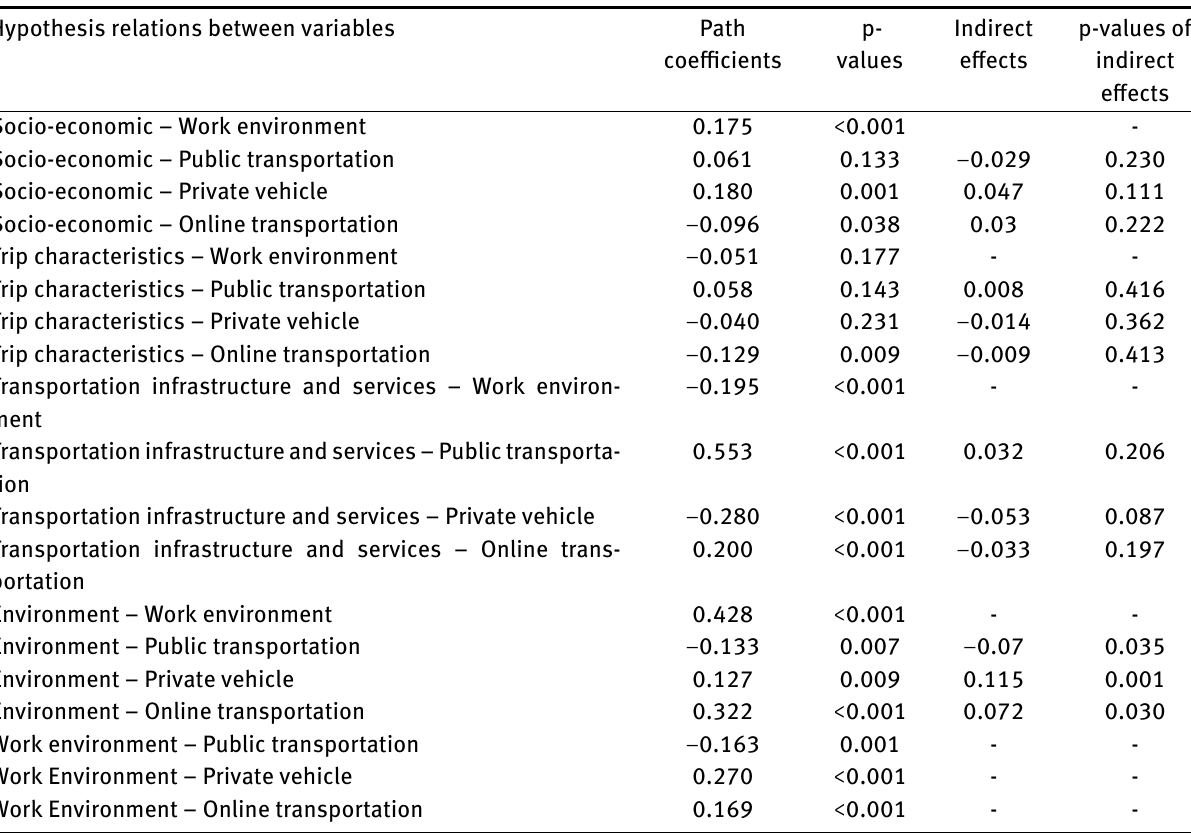
Table 8: Output test the relationship between variables in the model Hypothesis relations between